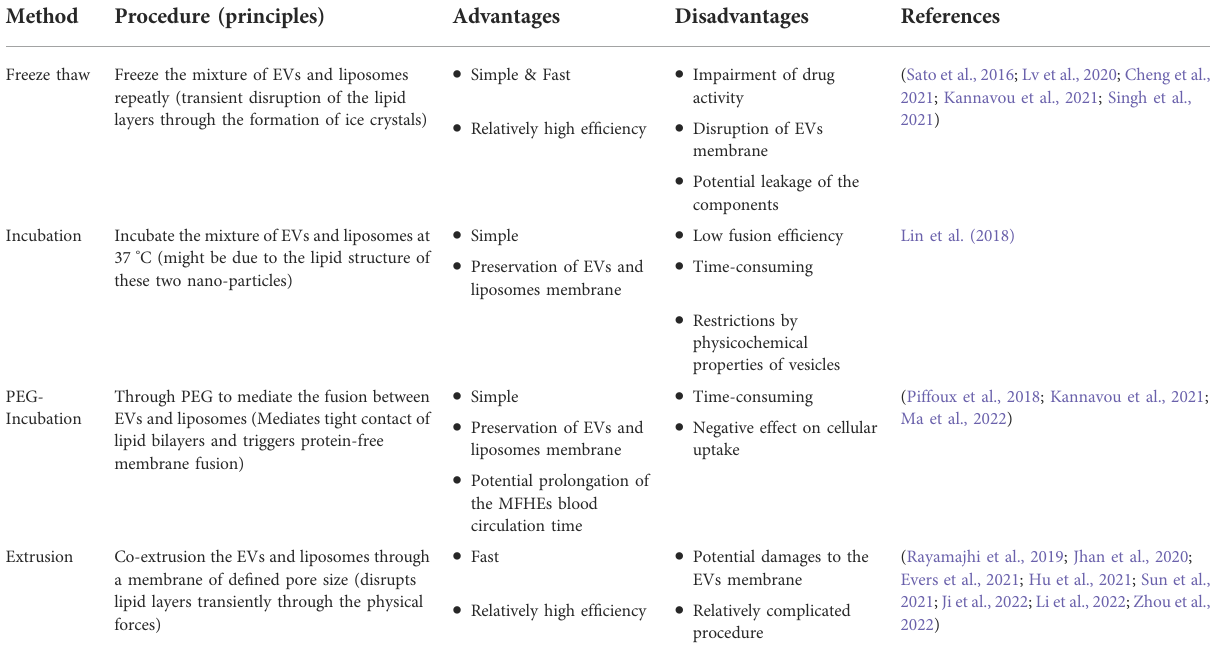
TABLE 1 Common methods for production of